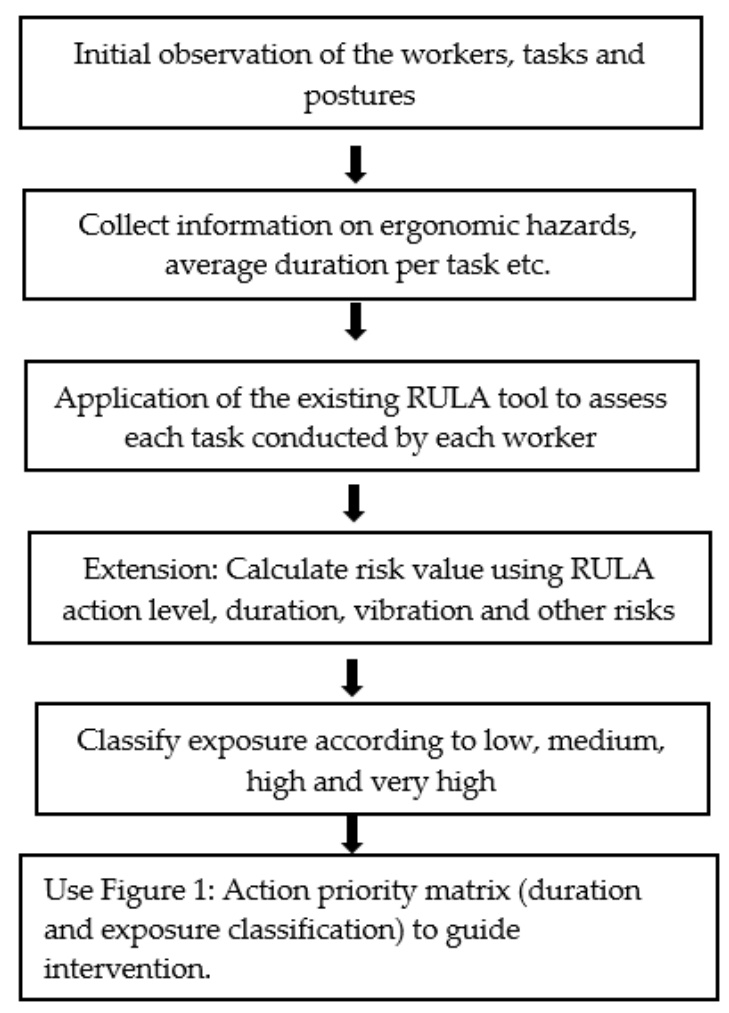
Figure 3. Details the application of the research in other informal work